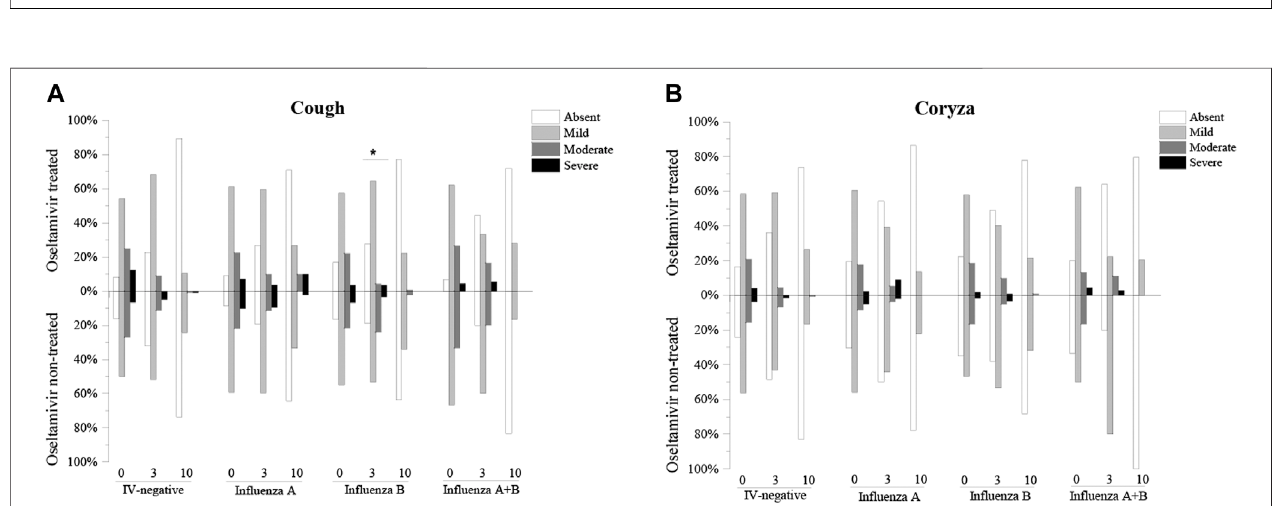
FIGURE 2 | Comparision of the severities of cough and coryza of oseltamivir treated and non-treated groups. (A) : Comparision of the severities of cough of oseltamivir treated and non-treated groups. (B) : Comparision of the severities of coryza of oseltamivir treated and non-treated groups.